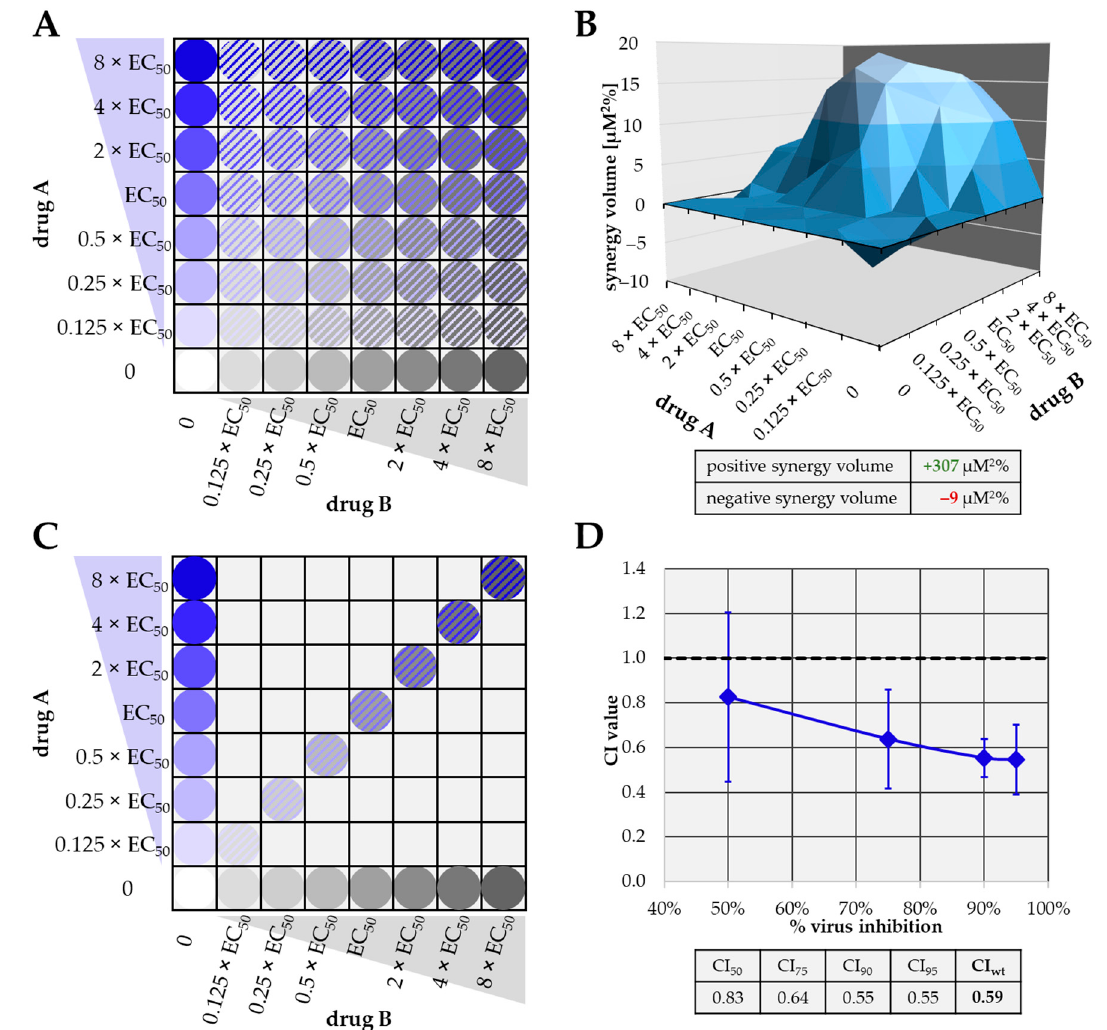
Figure 4. Characteristics of the Bliss independence checkerboard ( A , B ) and the Loewe additivity fixed-dose assays ( C , D ) adapted to the assessment of anticytomegaloviral drug combinations in vitro. ( A ) Schematic depiction of exemplary concentration combinations of drugs A (blue) and B (grey) employed in the Bliss independence checkerboard assay. ( B ) Exemplary synergistic result of a checkerboard assay. Positive synergy volume (volume above the 0 plane, green) as well as negative synergy volume (volume below 0 plane, red) are given in the table below. ( C ) Schematic depiction of exemplary concentration combinations of drugs A (blue) and B (grey) employed in the Loewe additivity fixed-dose assay. ( D ) Exemplary synergistic result of a fixed-dose assay. CI values at 50%, 75%, 90% and 95% virus inhibition as well as the calculated weighted CI value (CI wt ) are given in the table below. CI wt was calculated as (1 × CI 50 + 2 × CI 75 + 3 × CI 90 + 4 × CI 95 )/10. Note that the data shown in panels B and C are exemplary data from Figures 5 and 6. CI, combination index.